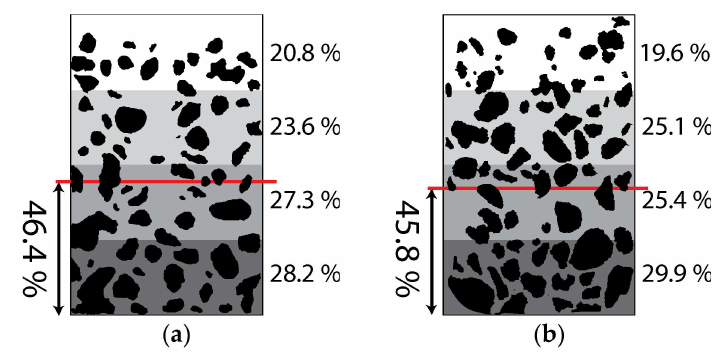
Figure 12. Average percentage of aggregate areas in each sub-area: ( a ) Test series A; ( b ) Test series C. Table 5. Aggregate concentration for each